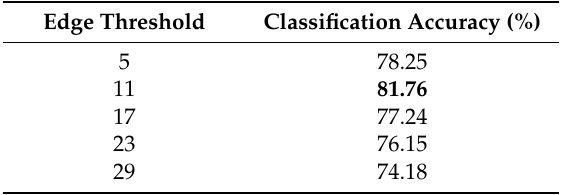
Table 4. Average classification accuracy of the SIFT over neuroblastic tumour dataset using different values for edge threshold ( C E ). Bold value indicates the highest classification